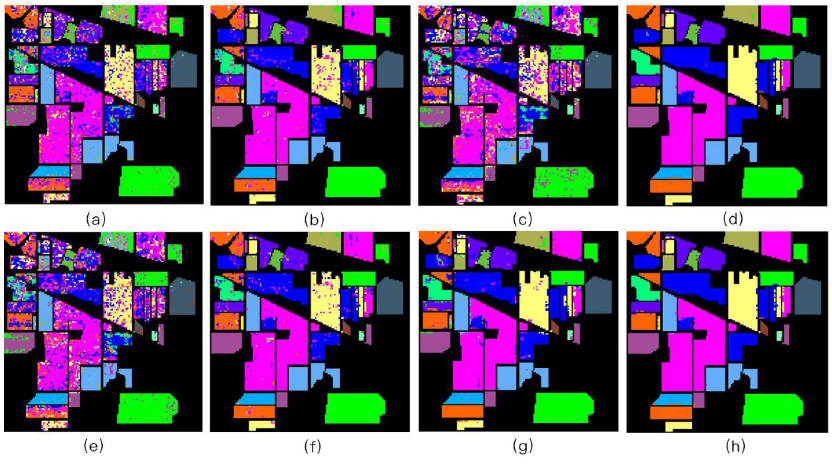
Fig 4. The Indian Pines image. (a) SVM [1] (OA = 72.26%); (b) JSR [17] (OA = 91.71%); (c) SR [16] (OA = 63.89%); (d) MASR [19] (OA = 96.91%); (e) NN-SR [18] (OA = 65.44%); (f) JNN-JSR [27] (OA = 93.12%); (g) WJNN-JSR [27] (OA = 93.65%); (h) WLSC-SR (OA = 98.21%).